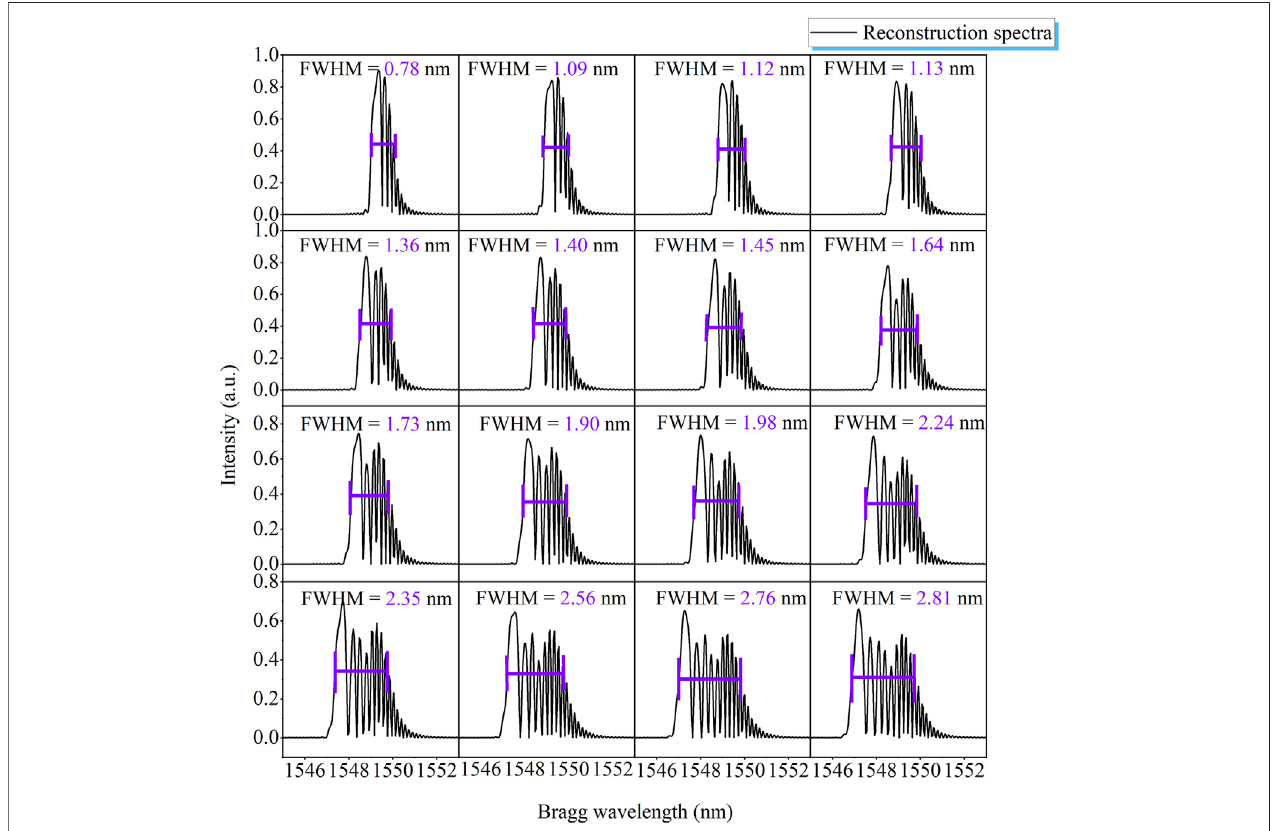
FIGURE 7 | Related spectra variations of FBG induced by different nonuniform strain distributions in glass-to-metal.